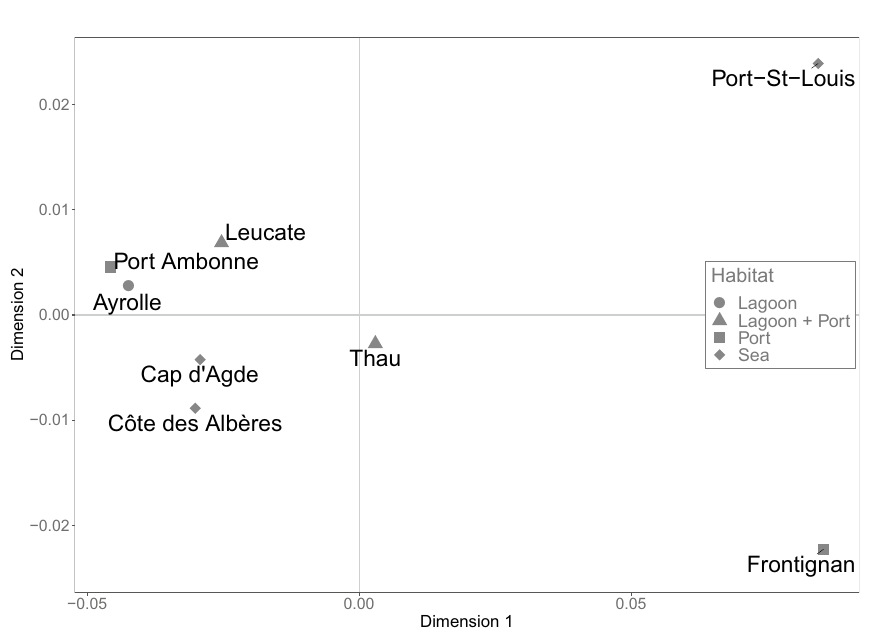
Figure 2. Multidimensional Scaling (MDS) based on Nei’s genetic distances among the 8 localities where Pinna nobilis individuals were